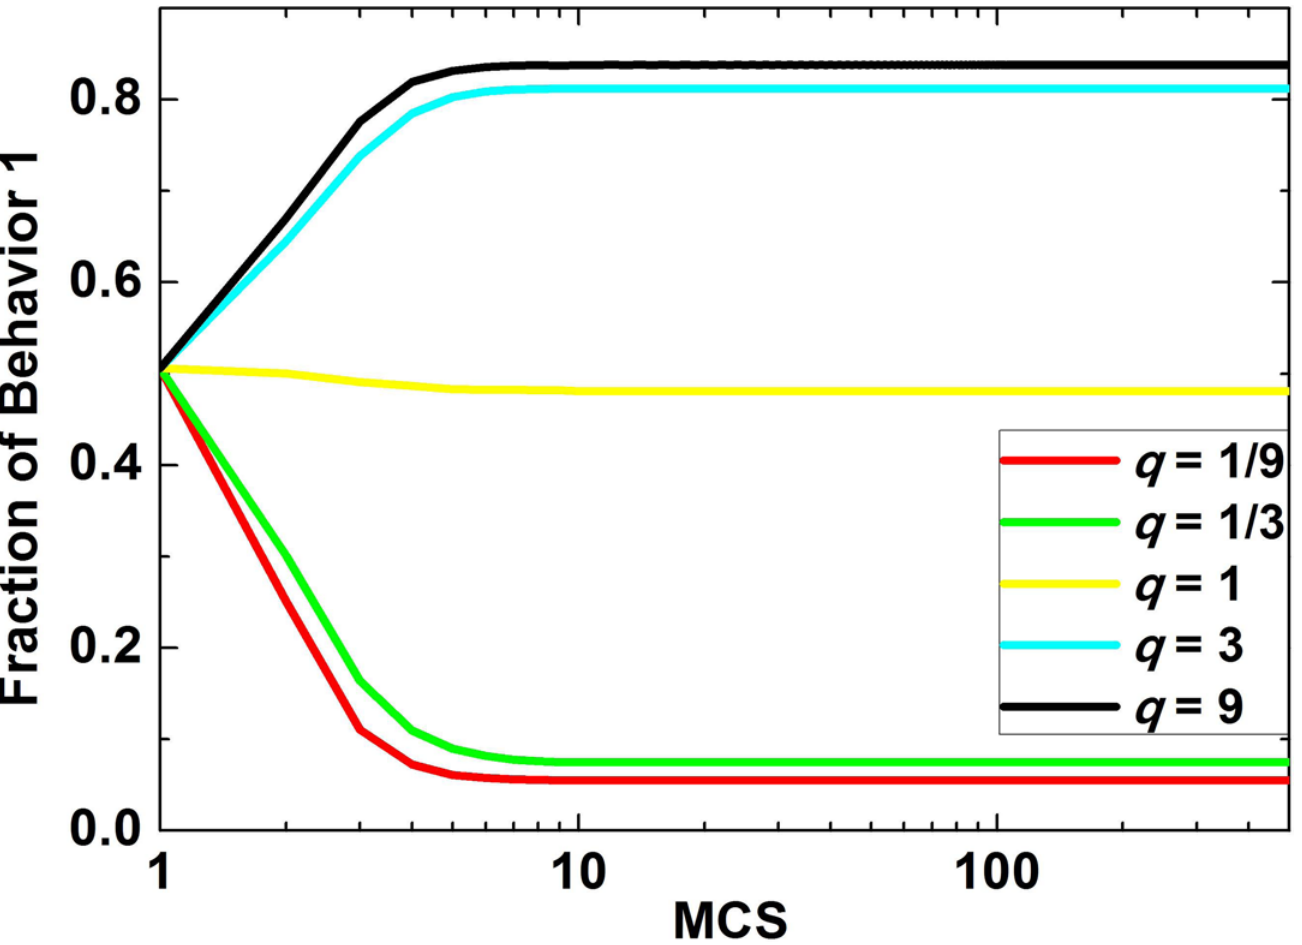
Fig 4. Fraction of behavior 1 in population which changes over time, when the fraction of small group 1 is fixed. In this figure, the five curves correspond to five different values of q . In detail, in the simulations f = 0.5, and the game parameters are selected as [ B 1 , B 2 , B 3 , B 4 , C 1 , C 3 ] = [2, 2, – 1, – 1, 1, 2], C 2 = C 1 / q , C 4 = C 3 / q and values of q are chosen as 1/9, 1/3, 1, 3, 9,